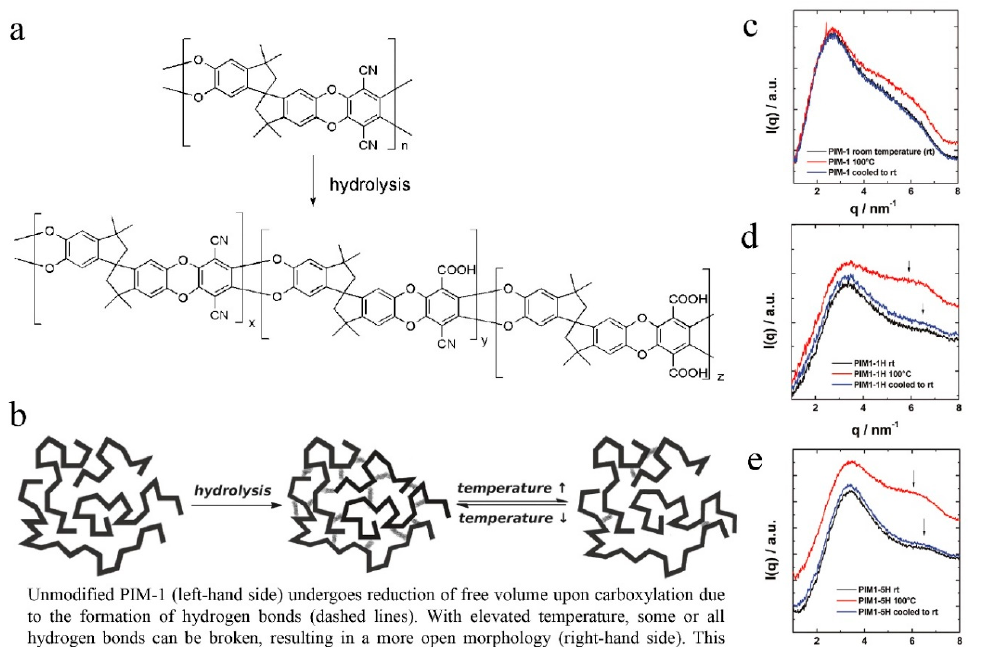
Figure 3. Reaction scheme for hydrolysis of PIM-1 ( a ), representation of the microstructural and hydrogen-bonding changes of PIM1 upon carboxylation ( b ), small-angle x-ray scattering (SAXS) patterns of samples (PIM-1 ( c ), PIM1-1H ( d ), and PIM1-5H ( e ). The membranes were initially measured at room temperature (rt), then at 100 °C, and again after cooling to room temperature. Adapted from Reference [42,43].